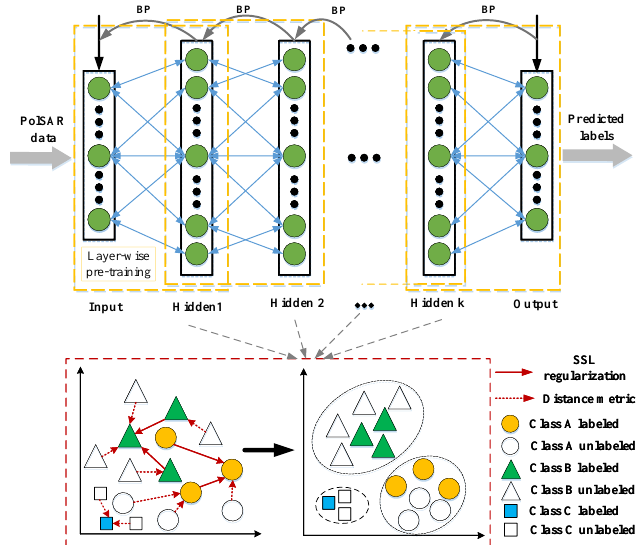
Figure 1. The architecture of our semi-supervised deep metric learning network